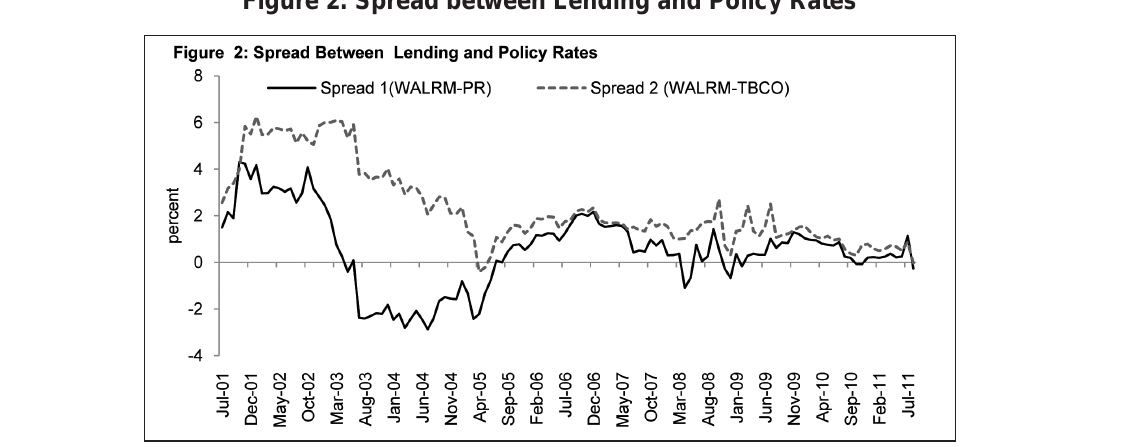
Figure 2: Spread between Lending and Policy